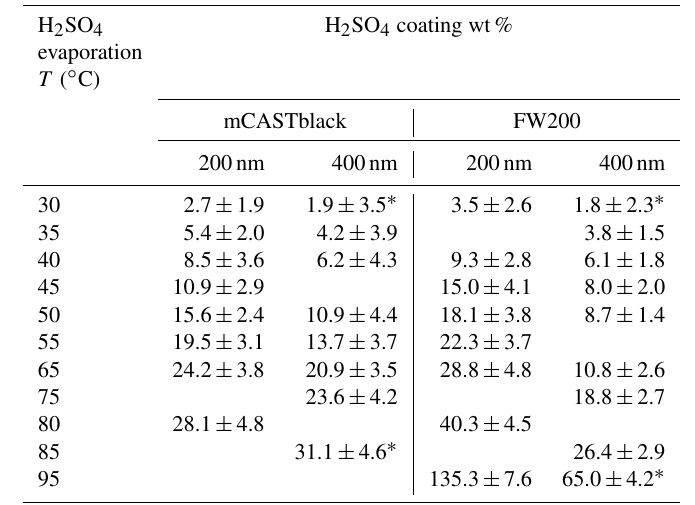
Table 1. The ratio of coated H 2 SO 4 mass to the bare soot particle mass (wt%) for 200 and 400nm mCASTblack and FW200 soot particles. The uncertainty represents 1 standard